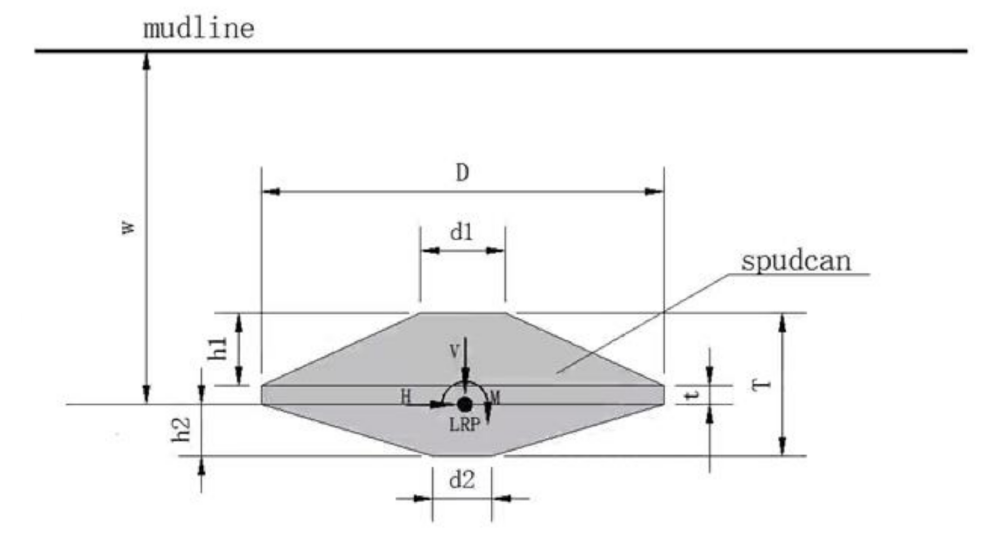
Figure 1. Spudcan foundation and sign conventions for loads and